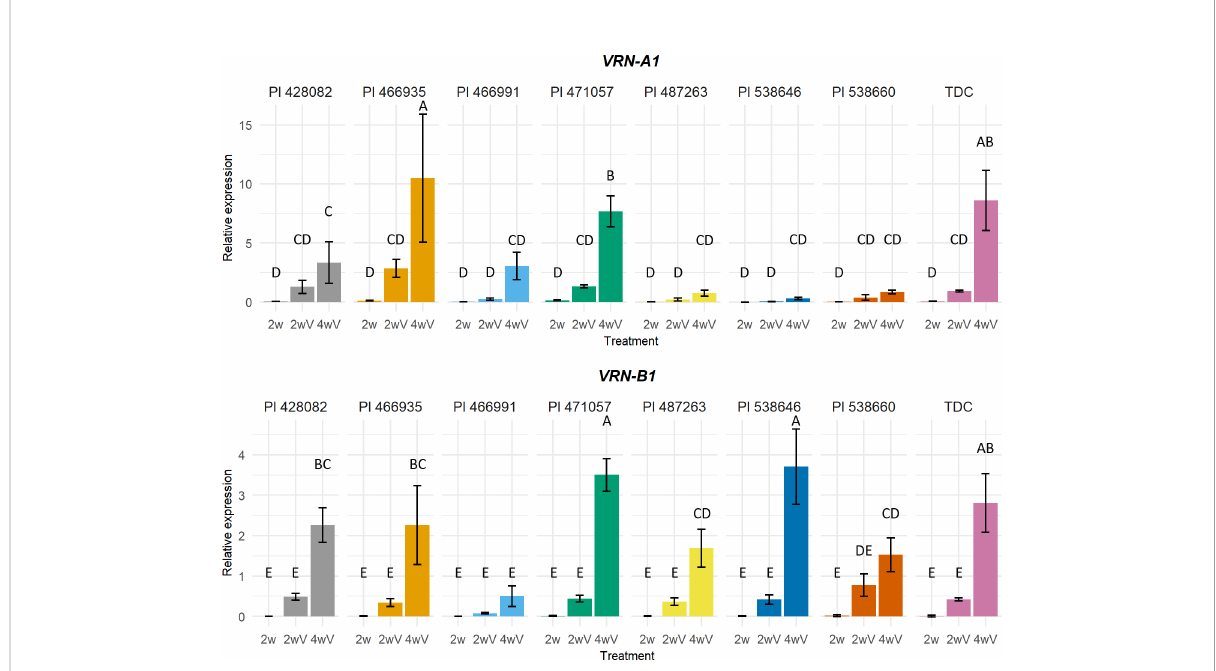
FIGURE 5 VRN-A1 and VRN-B1 expression pro fi les of PI 428082, PI 466935, PI 466991, PI 471057, PI 487263, PI 538646, PI 538660, and TDC. Expression data were analysed using one-way ANOVA with Duncan ’ s post-hoc test at a =0.05. Means that do not share a letter are statistically different.